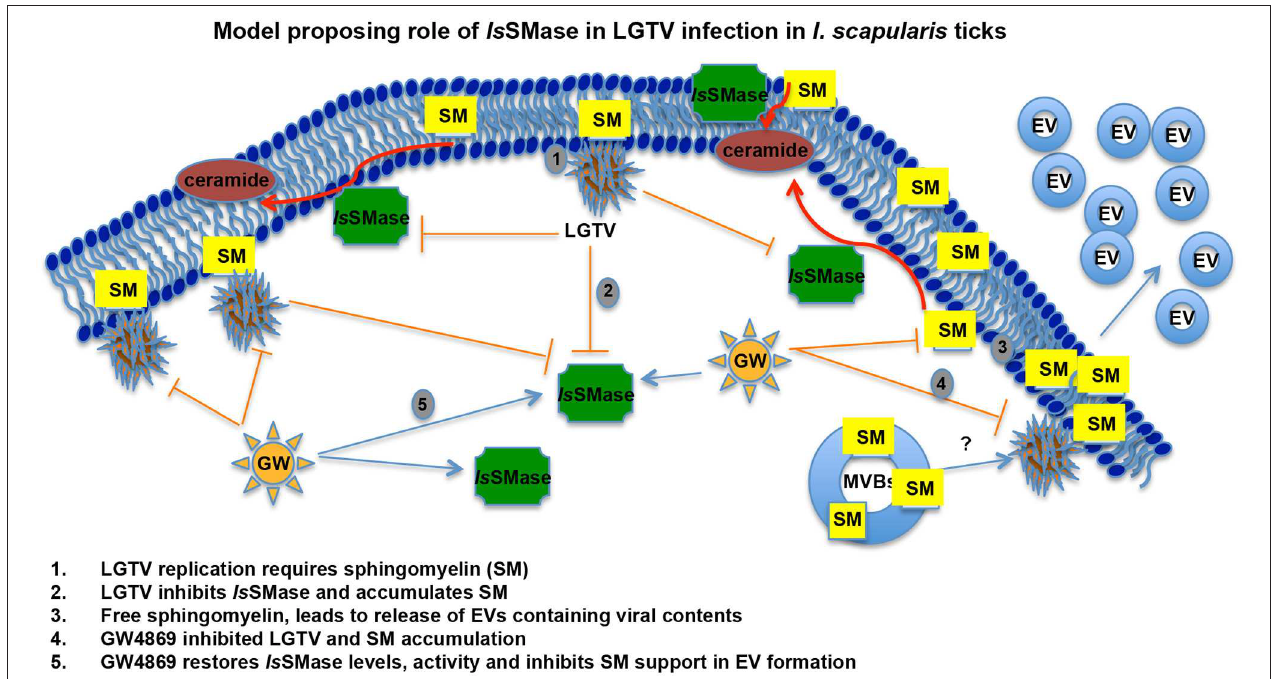
FIGURE 7 | LGTV modulates sphingomyelinase and sphingomyelin lipids for its replication and survival in tick cells. Schematic representation with a proposed model on how LGTV plays a role in the suppression of sphingomyelinase levels and its activity to induce SM lipid levels for its own benefit in membrane association and viral replication processes. Treatment with GW4869 inhibitor reduced LGTV loads to restore the sphingomyelinase levels and activity, thereby inhibiting the buildup of SM lipids. We hypothesize that accumulated amounts of SM lipids not only support membrane-associated viral replication but also aid in the production and release of exosomes/EVs that mediate viral exit and dissemination. SM indicates sphingomyelin, EVs represents extracellular vesicles, and MVBs denotes multi-vesicular